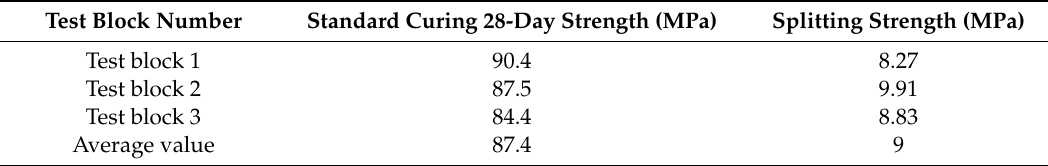
Table A8. Concrete strength obtained from the experimental test on standard C80 HPC cubic specimen.